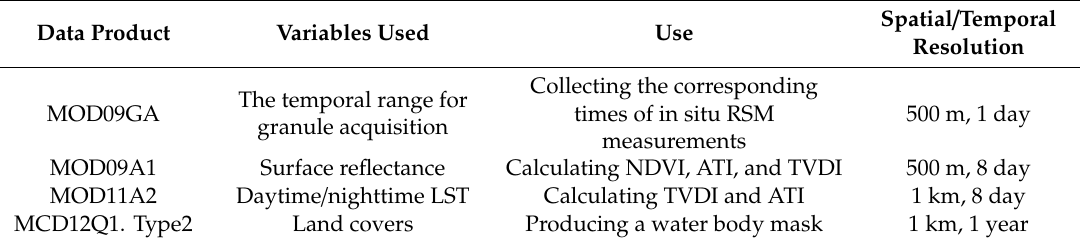
Table 1. MODIS data used in the